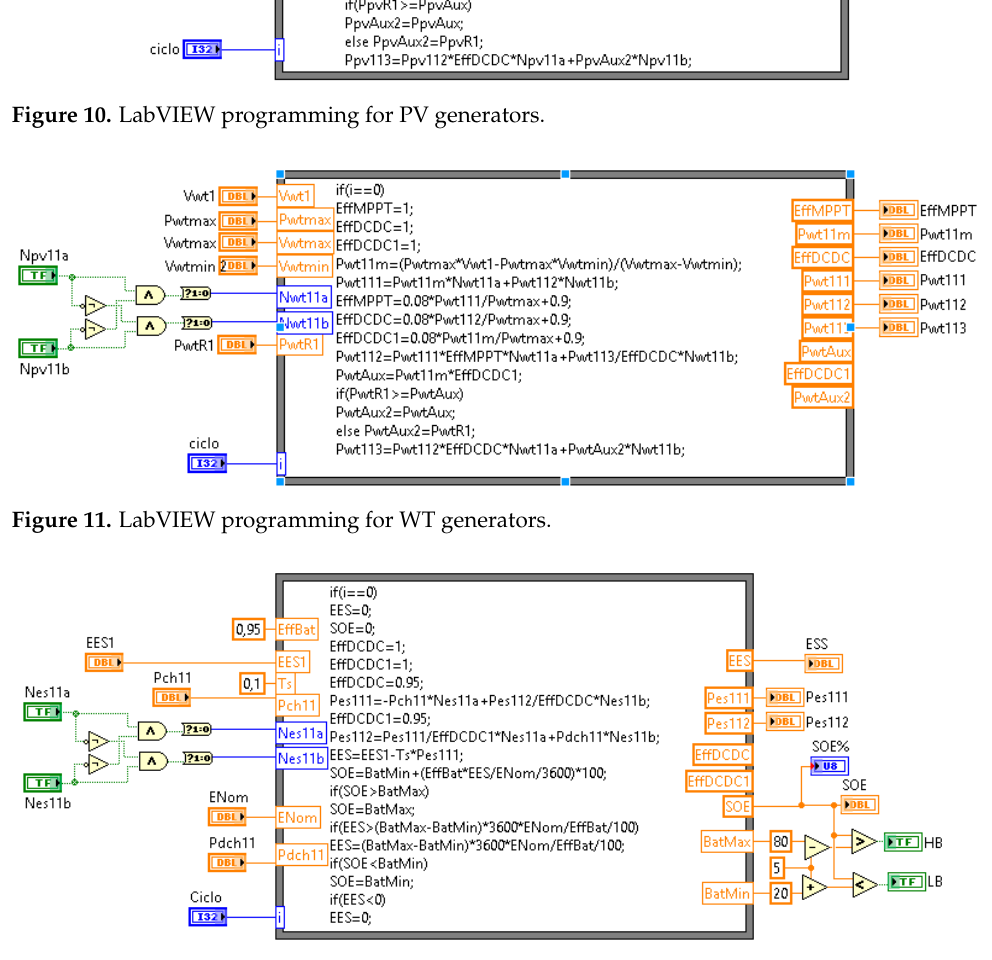
Figure 12. LabVIEW programming for ESUs.